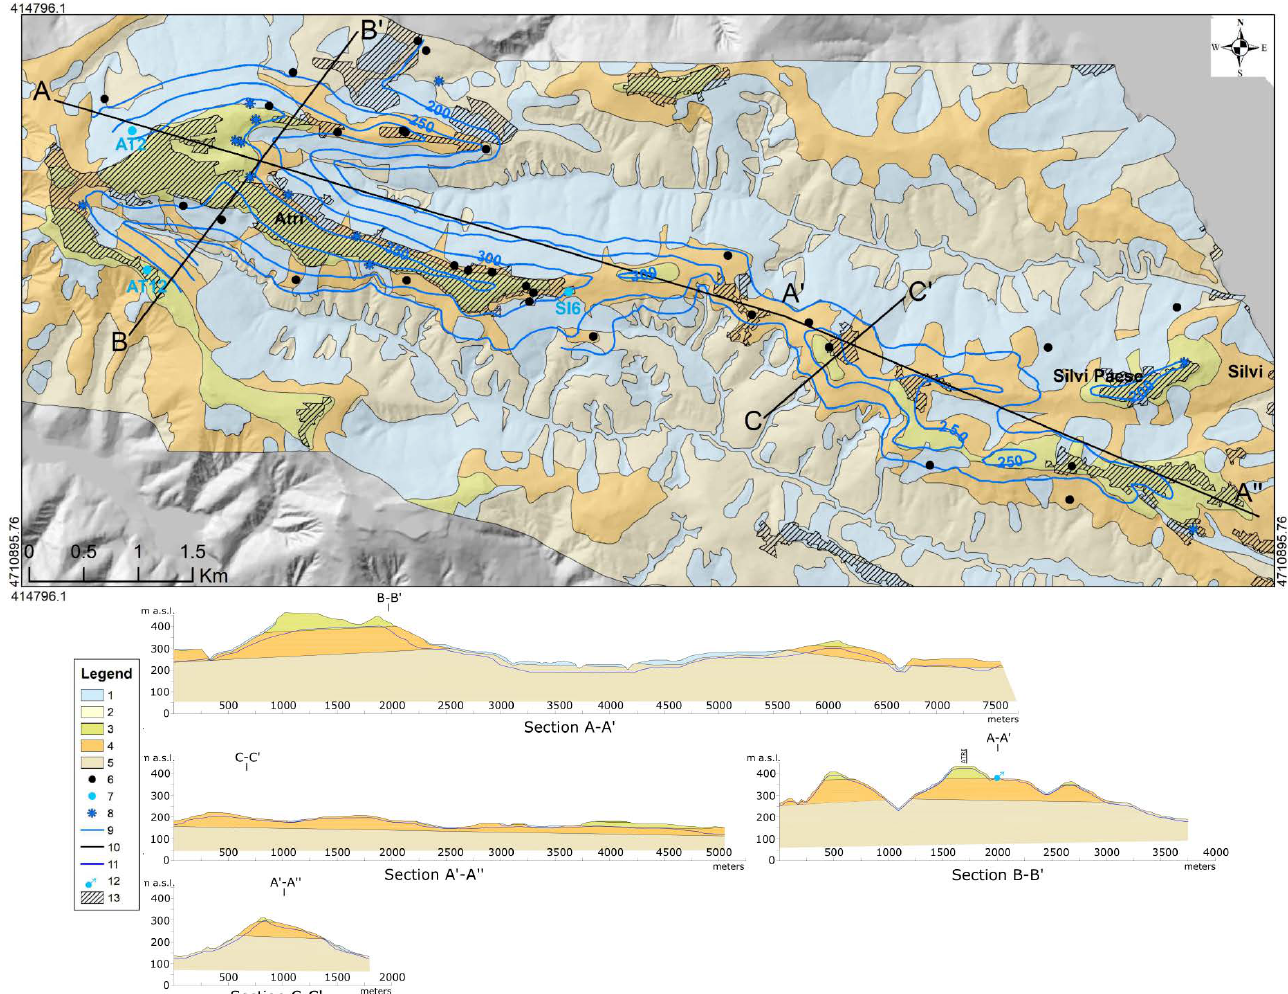
Figure 6. Geological map and cross-sections of the AS area. (1): Recent alluvial and slope deposits (Holocene); (2): Alluvial deposits (Middle Pleistocene-Holocene); (3): Sandy-gravelly deposits (Middle-Upper Pleistocene); (4): Sandy-clayey deposits (Lower Pleistocene); (5): Marly-clayey deposits (Middle-Upper Pliocene); (6): Sampling well; (7): Pumping test well; (8): Spring; (9): Winter water table contour (m a.s.l.); (10): Cross-section trace; (11): Water table (in cross-section); (12): Spring (in cross-section); (13): Urban